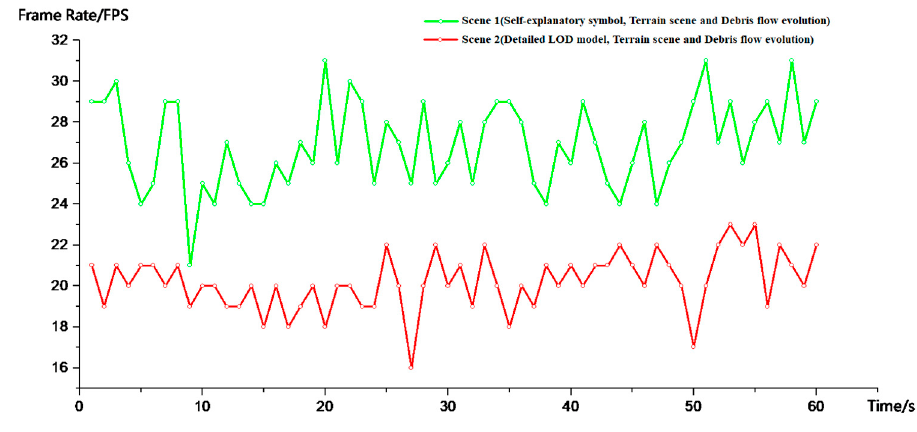
Figure 13. Tests of the difference between scene 1 and scene 2 on the rendering frame rate.